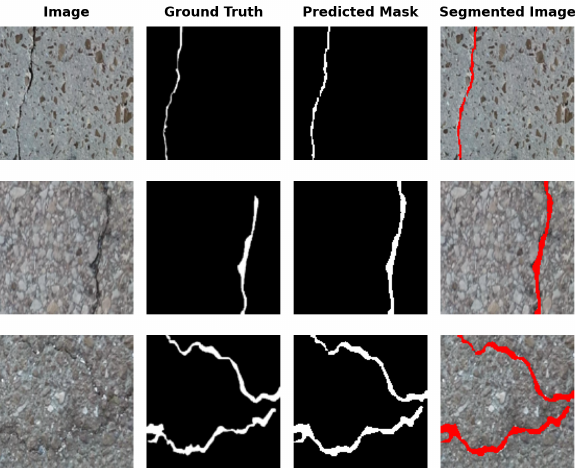
Figure 4. Prediction of network on the test data set.